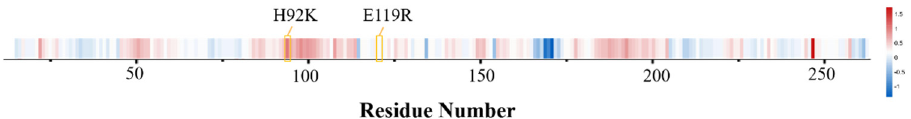
Figure 7. The RMSF results of WT and H92K/E119R after MD at 300 K are represented by the difference value, and displayed in the form of a heat map.